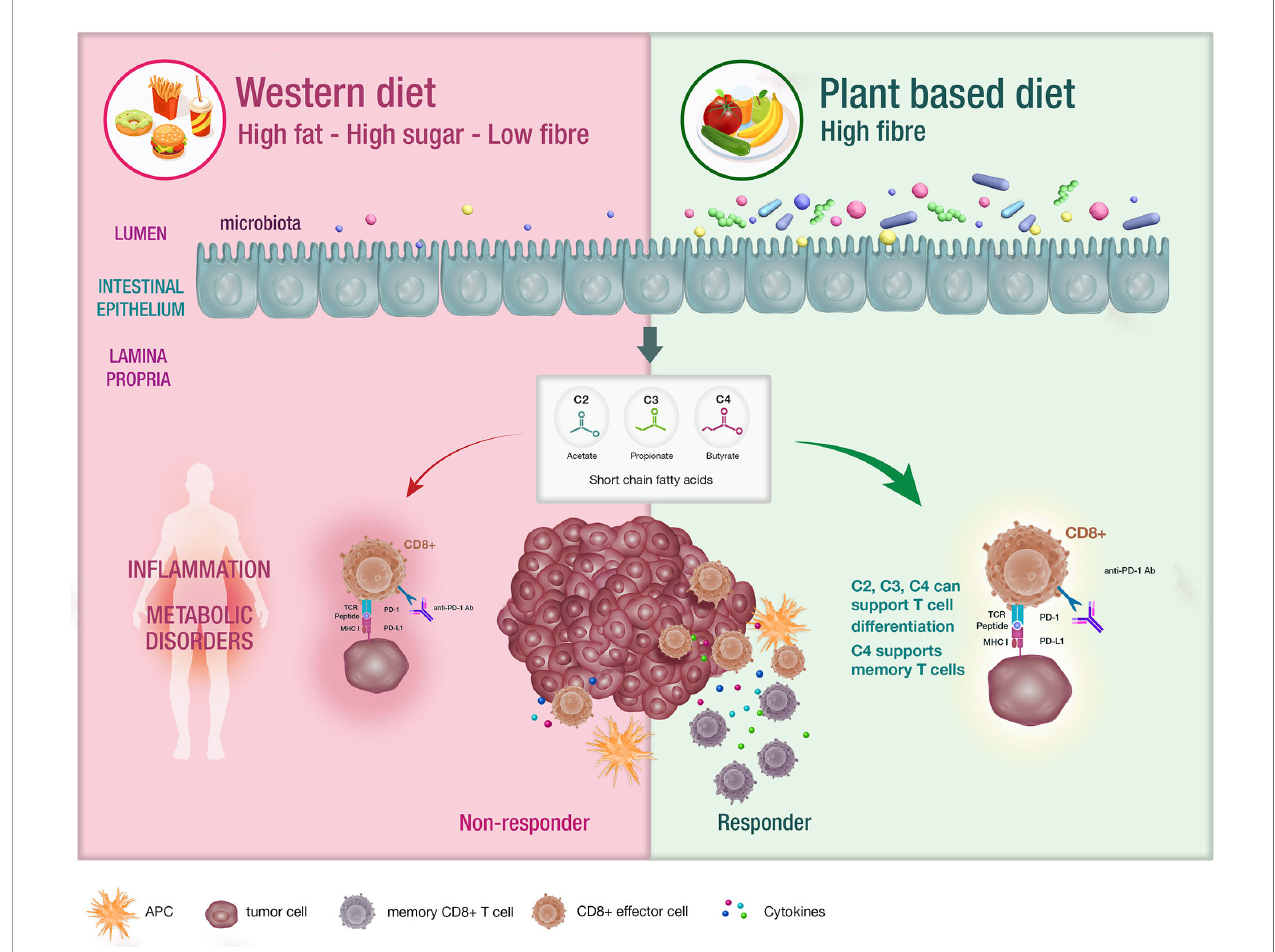
FIGURE 1 | The impact of diet on the microbiota and systemic immunity. Diet has an impact on the host microbiota with the western diet being linked with dysbiosis. Conversely, diets that are high in fi bre have been associated with bacterial diversity in the microbiota , which is postulated to support appropriate T cell differentiation. These patients are likely to experience enhanced responses to